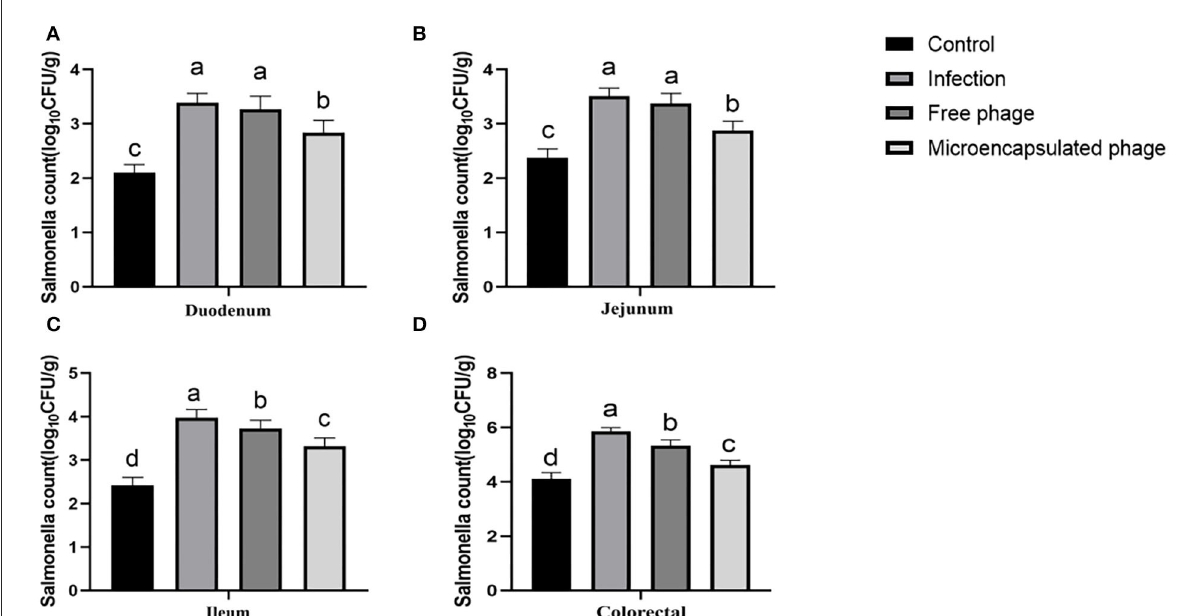
FIGURE5 Therapeutic effect of microencapsulated phages on infected chicks. (A) Changes in the number of Salmonella colonization in duodenum. (B) Changes in the number of Salmonella colonization in jejunum. (C) Changes in the number of Salmonella colonization in ileum. (D) Changes in the number of Salmonella colonization in colorectal. The same lower letters represents no significant difference ( P > 0.05) between the groups, different lower letters represent significant differences ( P < 0.05) between the groups. Each value in the figure represents the mean ± SD ( n =